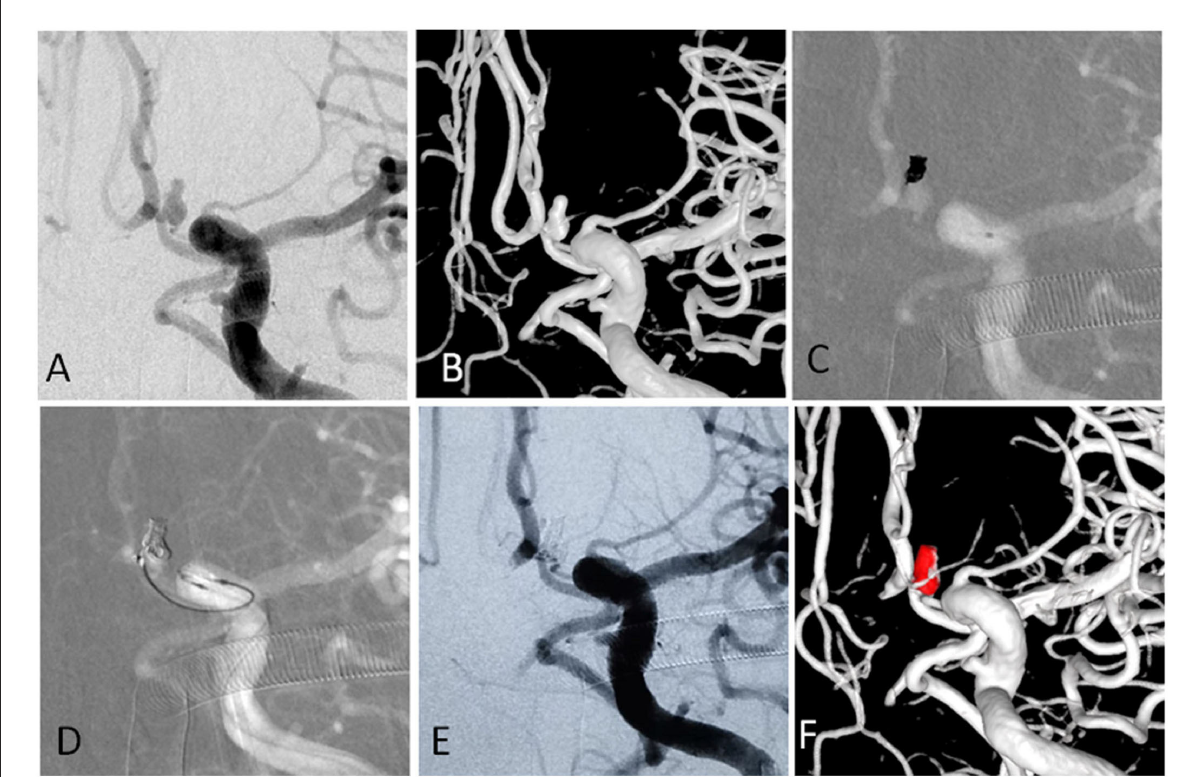
FIGURE3 (A,B) The angiographic and 3-D imaging showed an anterior communicating artery complex aneurysm. Heubner artery originated from the neck. (C) The first microcatheter was navigated into the aneurysm, and the first coil was fully advanced into the aneurysm. (D) The second microcatheter was navigated into the aneurysm to protect the Heubner artery from being occluded. (E,F) The aneurysm was completely occluded, and the Heubner artery was patent.